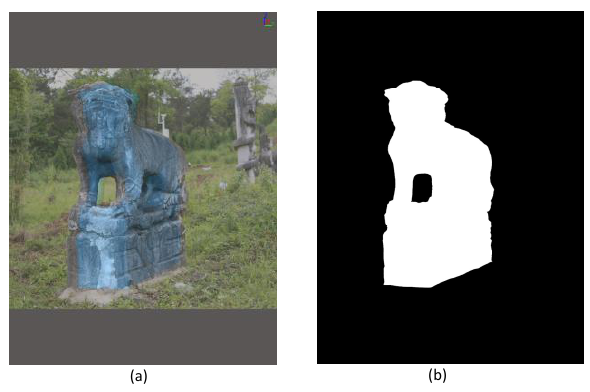
Figure 4. Target block area in depth image from 3d model. For simple object, we can combine this binary image with colourful texture image to find out the target area, denoted in figure 4 white area as front and black as back ground. But the 3d model sometimes contains a few holes, using the binary image block directly to label the texture image into front and back is not sufficient. Meanwhile, 3d model cannot overlap all the target image area for we didn’t require a precise 3d model position setting.